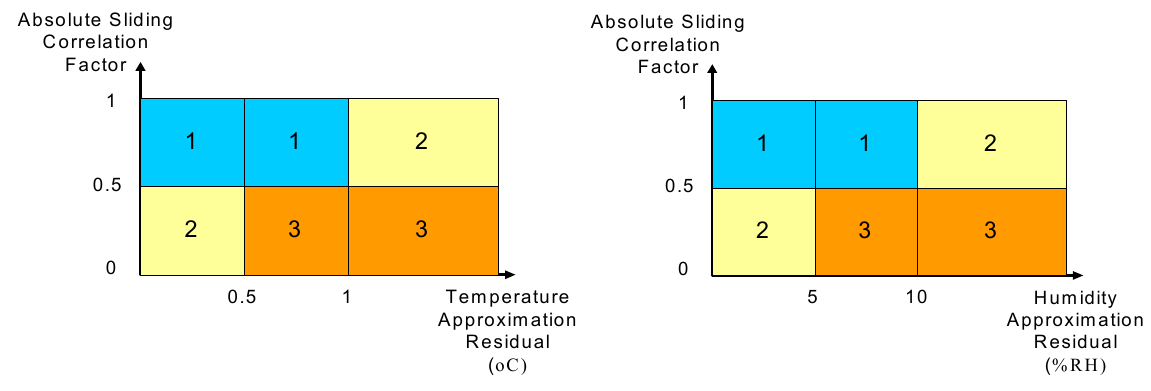
Figure 13. Classification